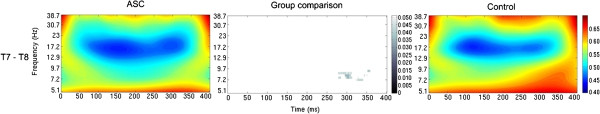
Mann–Whitney group comparison of interhemispheric coherence, corrected for multiple comparisons using False Discovery Rate (FDR). The colored graphs represent values of wavelet coherence for the ‘faces’ task, for every time-frequency point, for each group (ASC: left column, controls: right column) and for electrode pair T7-T8; areas in blue represent regions of low coherence in the time-frequency spectrum, while areas in red represent regions of high coherence. The graph in the middle represents the FDR-corrected statistical group comparison for electrode pair T7-T8; areas shaded gray represent regions of the time-frequency spectrum where there is a significant decrease of coherence for the ASC group compared to the control group, at PFDR-corrected <0.05. No areas were found where there were significant group differences after FDR correction for any other electrode pairs or task.